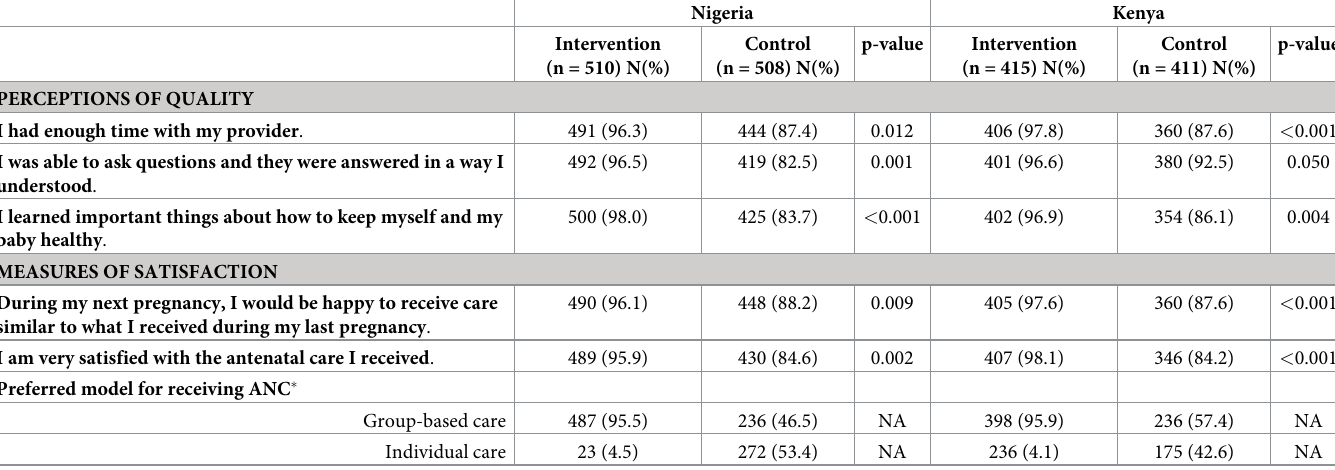
Table 4. G-ANC effect on client perceptions of quality, satisfaction, and ANC model